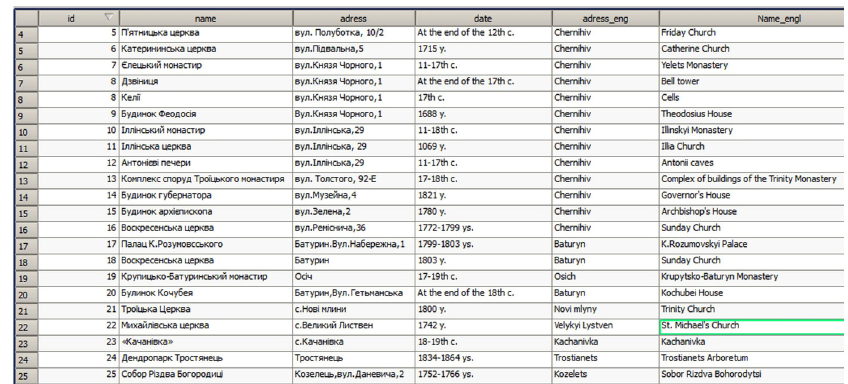
Figure 1. A fragment of table “Cultural objects” of Chernihiv region